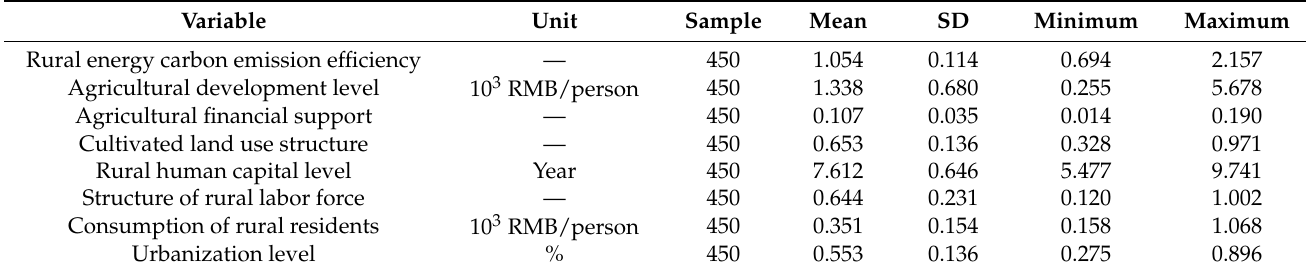
Table 1. Descriptive statistics of variables.